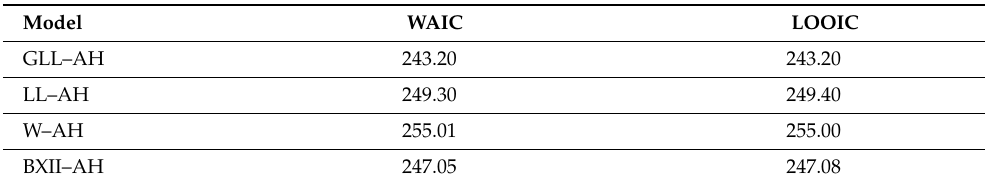
Table 8. Bayesian model comparison for the GLL–AH and its special cases including LL–AH, W–AH, and BXII–AH